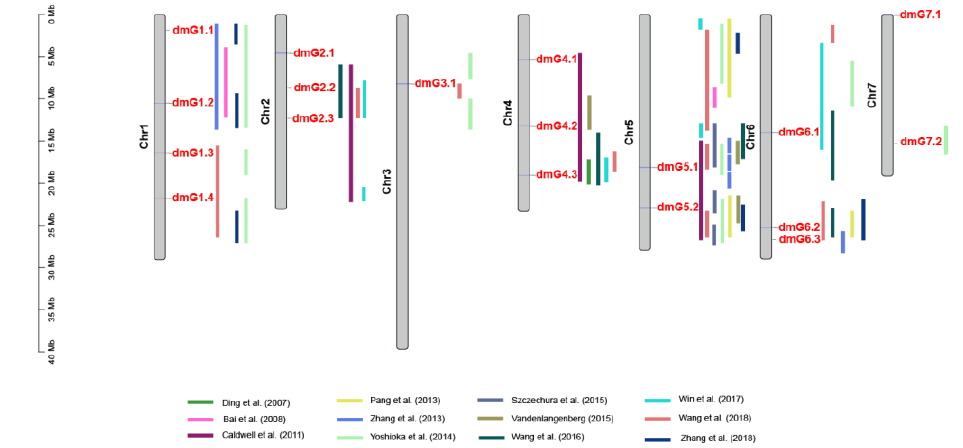
Figure 4. Locations of QTLs for downy mildew resistance in cucumber reported in this study and previous studies (2007–2018). The red font indicates the loci of this study and their exact SNP locations can be found in Supplementary file 4.